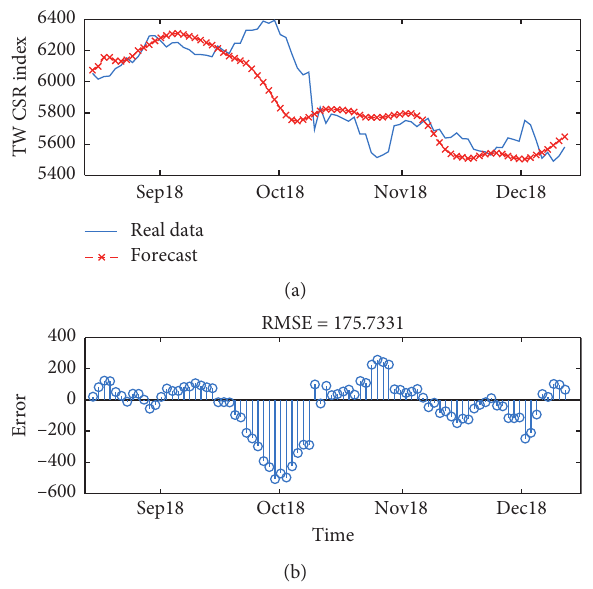
Figure 24: Addition of all LSTM EMD prediction results compared to the actual verification RMSE of 175.7331.